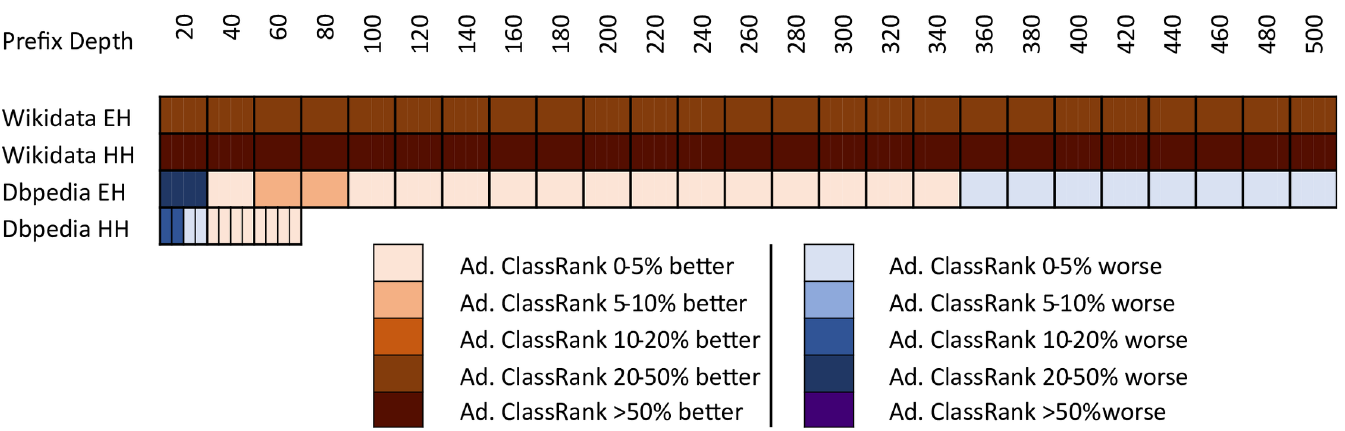
PLOS ONE | https://doi.org/10.1371/journal.pone.0252862 June 10,